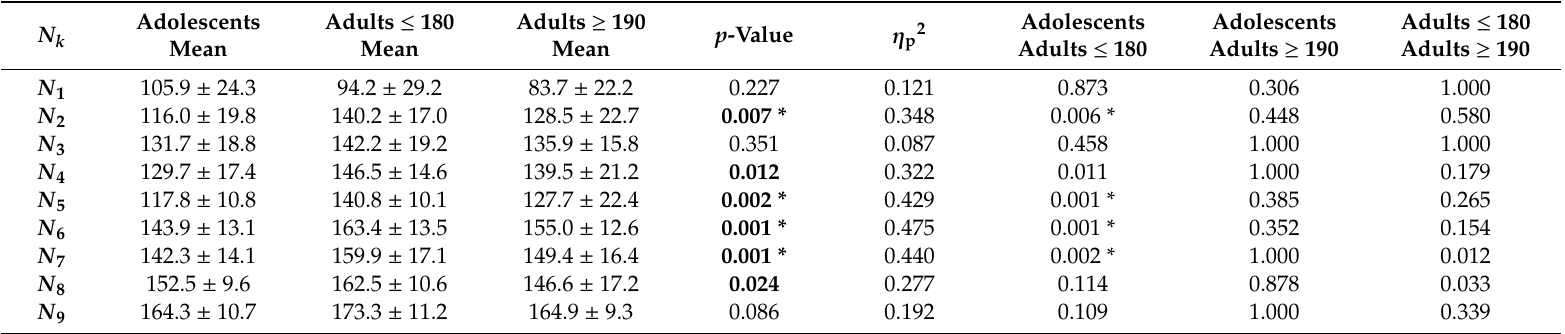
Table 6. Group di ff erences of N k in the di ff erent movement components are presented. Results from eyes-open and eyes-closed conditions were pooled due to the absent eye condition e ff ect. The means ± SD of the adolescents, small ( ≤ 180 cm) and tall ( ≥ 190 cm) adults and corresponding p -values are displayed. Bold p -values indicate p < 0.05, asterisks (*) mark significant di ff erences after Holm-Bonferroni correction. E ff ect sizes are presented as η p2 (partial eta-square). p -values related to post-hoc test between all three groups are displayed on the